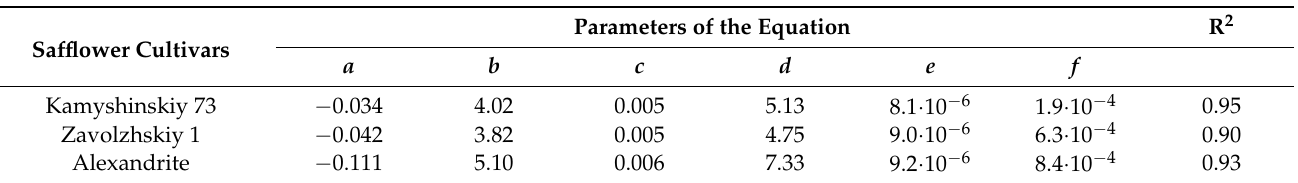
Table 3. Parameters of the response equation for the dependence of the yield of safflower on the seeding rate and tillage